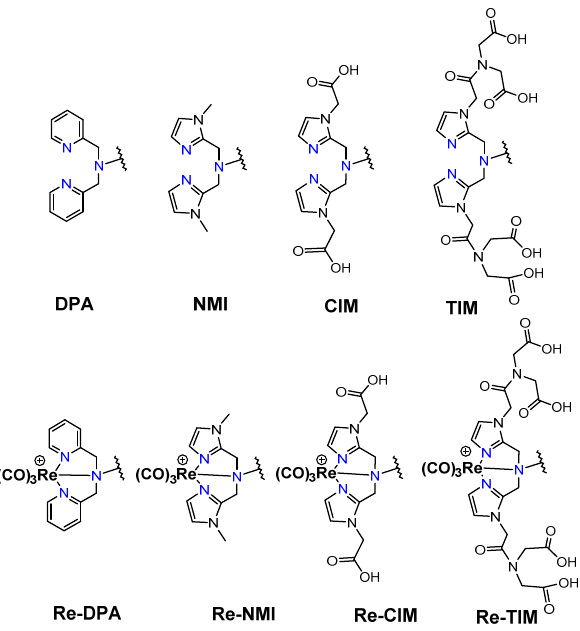
Figure 9. General structure of the SAAC Lys-based bifunctional chelator and corresponding Re com- plexes.